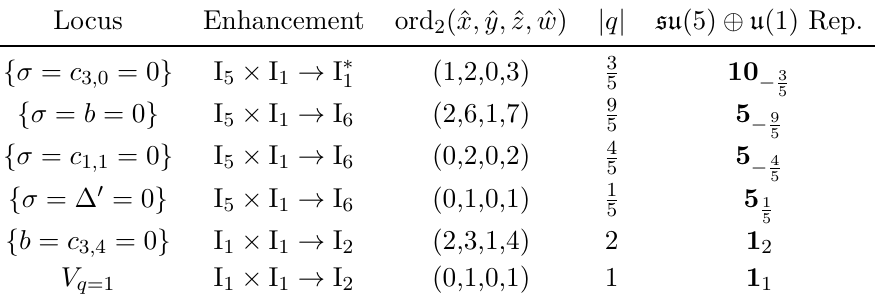
Table 3. Matter loci for su (5) ⊕ u (1) example along with the codimension-two orders of vanishing of the section components. For typographical reasons, we describe the singularity types using the Kodaira notation rather than the associated ADE gauge